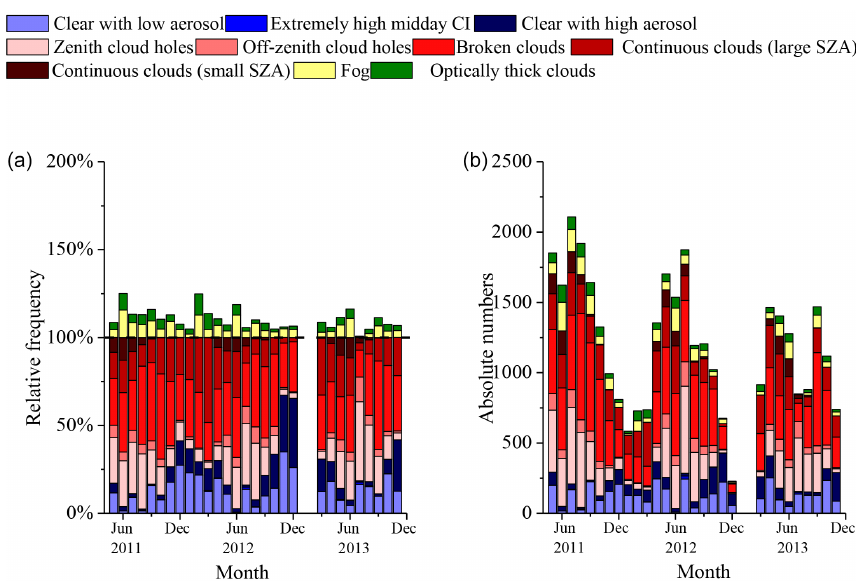
Figure 10. The monthly frequency distribution of the cloud classification scheme. (a) Relative frequencies of the different sky conditions (indicated by the different colors). Bars between 0 and 100% represent the frequency of the primary sky conditions; bars above 100% represent the frequency of the secondary sky conditions. The black dashed line emphasizes the 100% mark. (b) Accumulated absolute numbers of the sky conditions in each month.